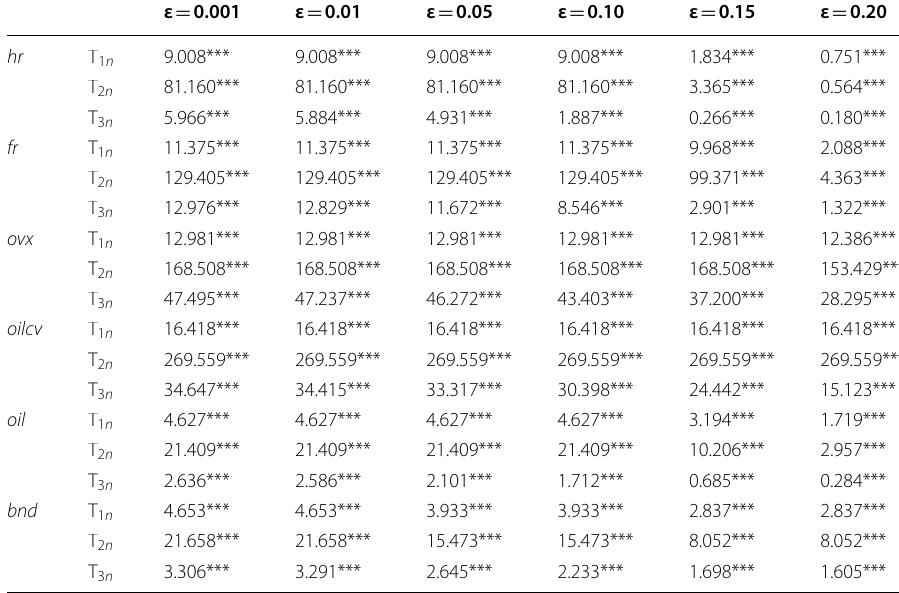
* , **, *** denote significance at 10%, 5% and 1% level, respectively. T1, T2, T3 refer to Bera et al. (2016) statistics: T 1 n :=